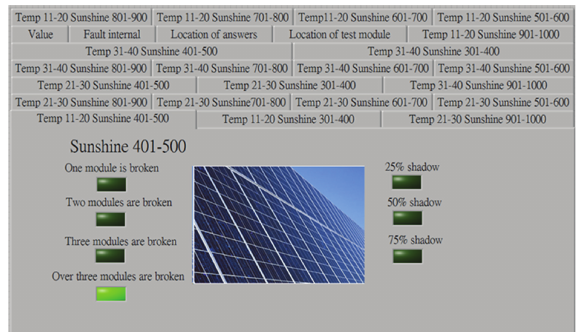
Figure 12: The display interface of fault diagnosis.